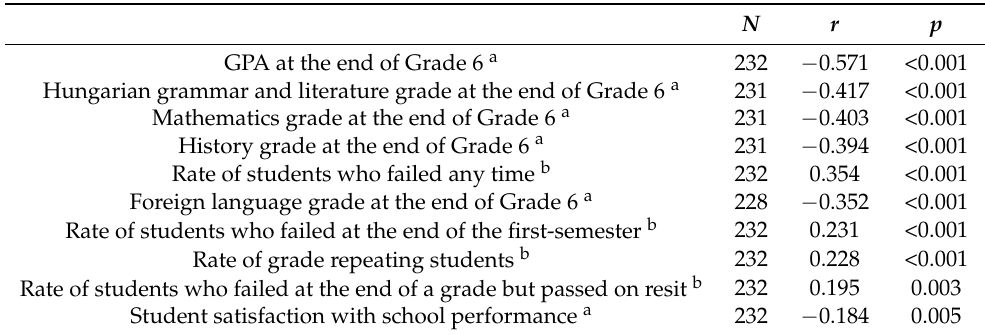
Table 2. Correlation between the dropout index of Grade 7 and the individual academic achievement indicators aggregated by